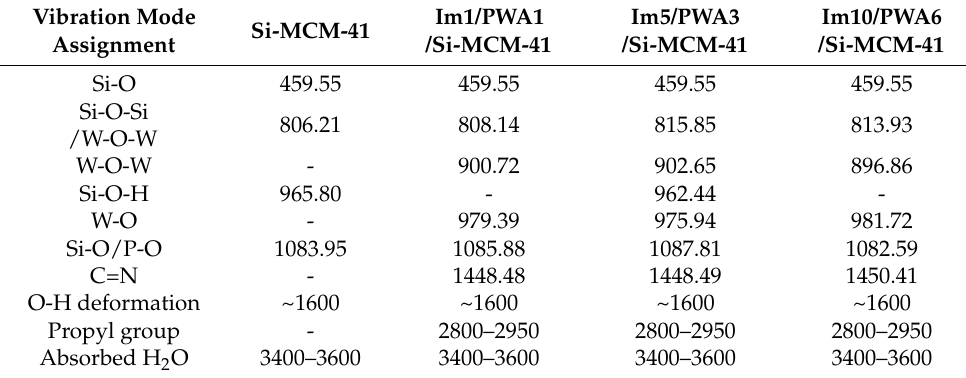
Table 2. FT-IR spectra Peak Assign for Im(x)/PWA(y)/Si-MCM-41.